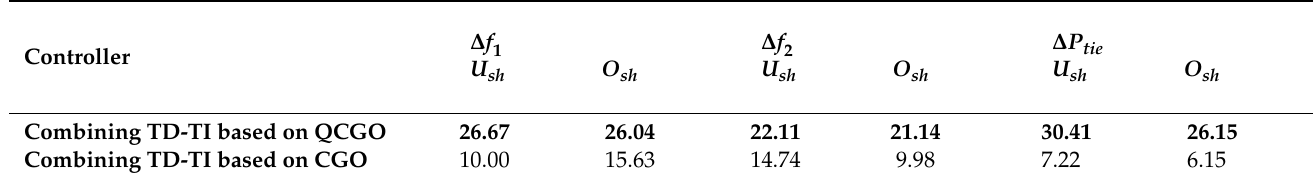
Table 19. Percentage improvement in U sh and O sh values for combining TD-TI/QCGO and combin- ing TD-TI/CGO based on combining TD-TI/SSA for scenario